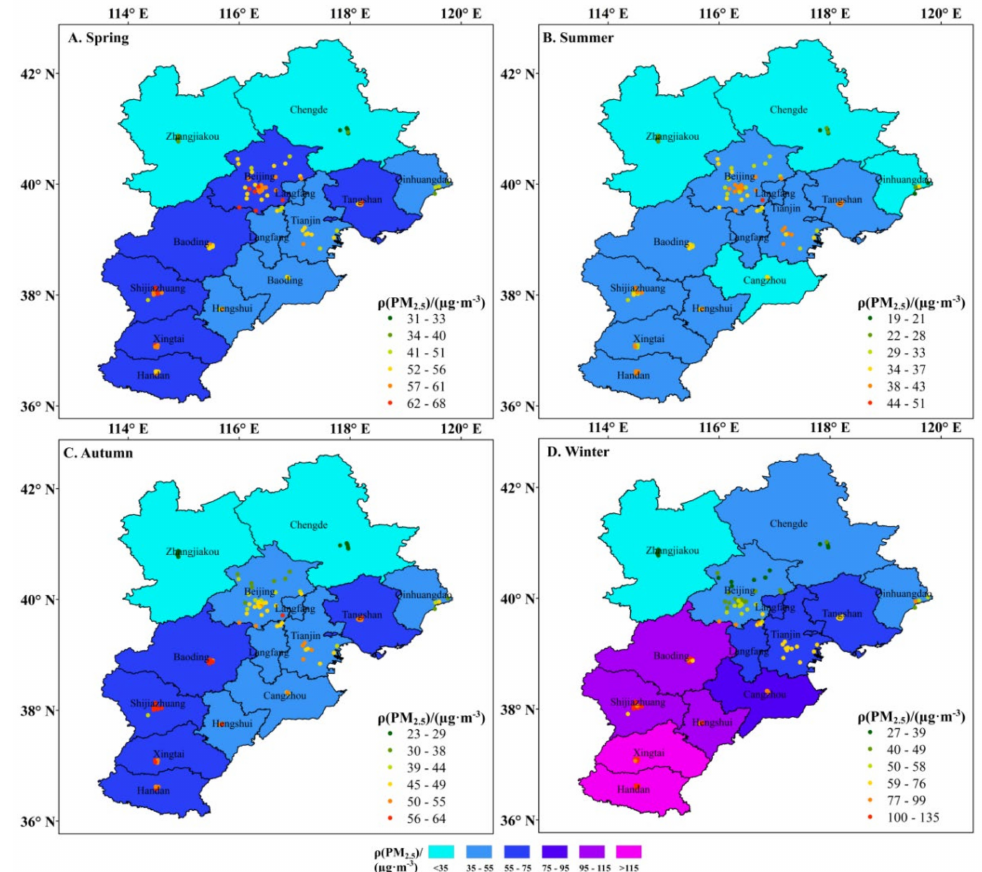
Figure 6. Seasonal PM 2.5 distributions across the Beijing-Tianjin-Hebei region from 2018 to 2019. (The ( A – D ) diagram represents the spatial distribution of PM 2.5 in spring, summer, autumn and winter